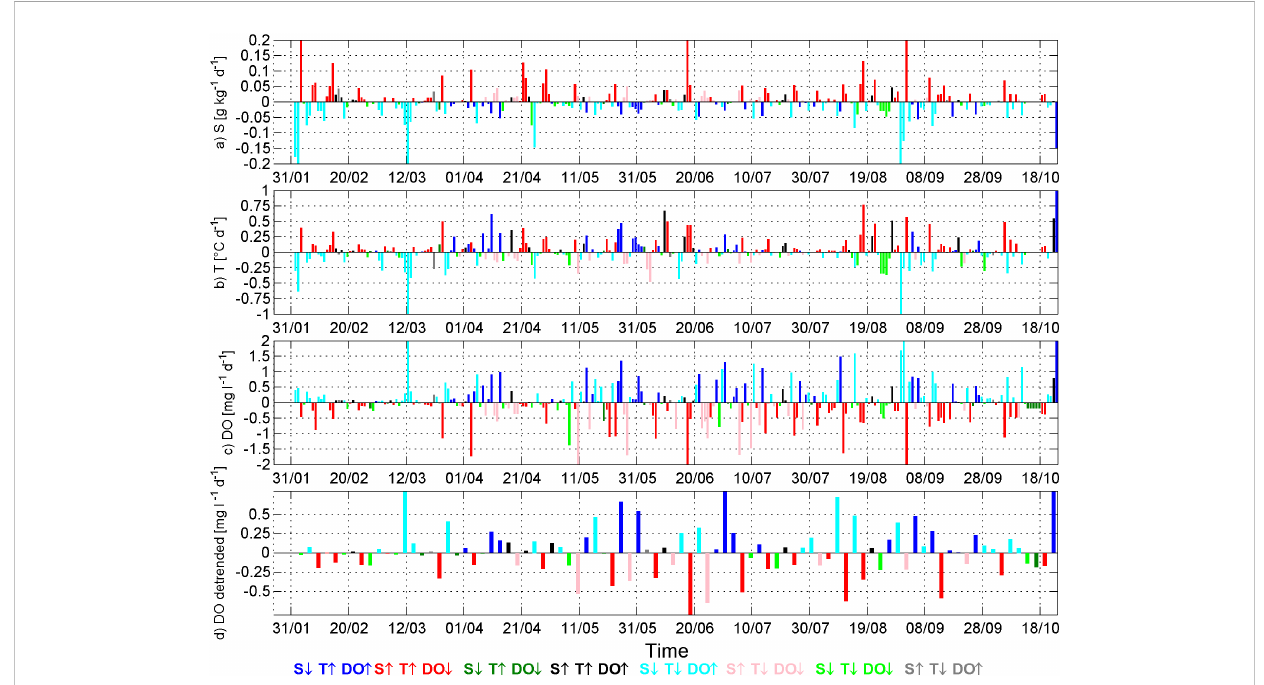
FIGURE 3 Daily changes in salinity, temperature, and oxygen (A – C) from 28 January to 23 October 2021. Detrended (according to the linear trends shown in Figure 2C) 3-day mean changes of oxygen (D) . Colors show the positive or negative changes of variables, as shown at the bottom of the fi